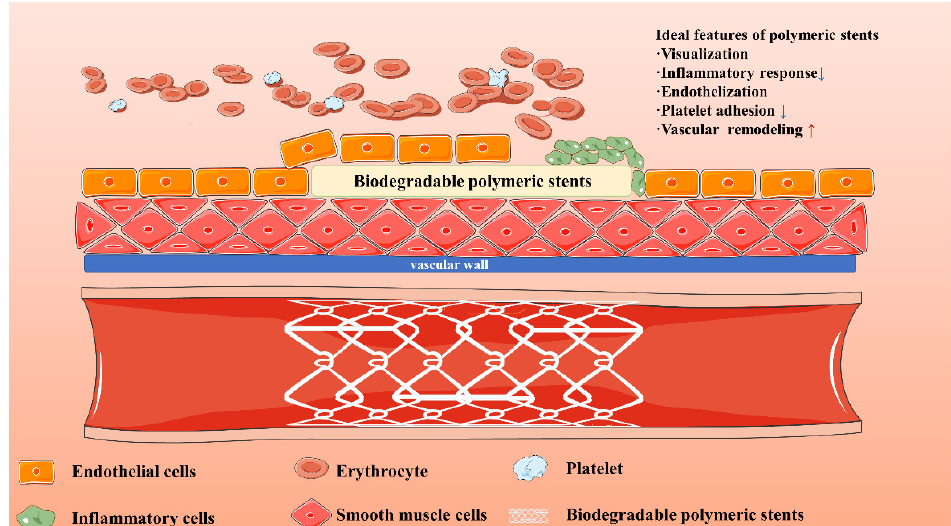
Figure 6. Ideal features of biodegradable polymeric stents. The features of stents including visualization, inflammatory response, endothelization, platelet adhesion, and vascular remodeling should be considered (red arrow ↑ indicates the promotion effect, blue arrow ↓ indicates the inhibition effect).